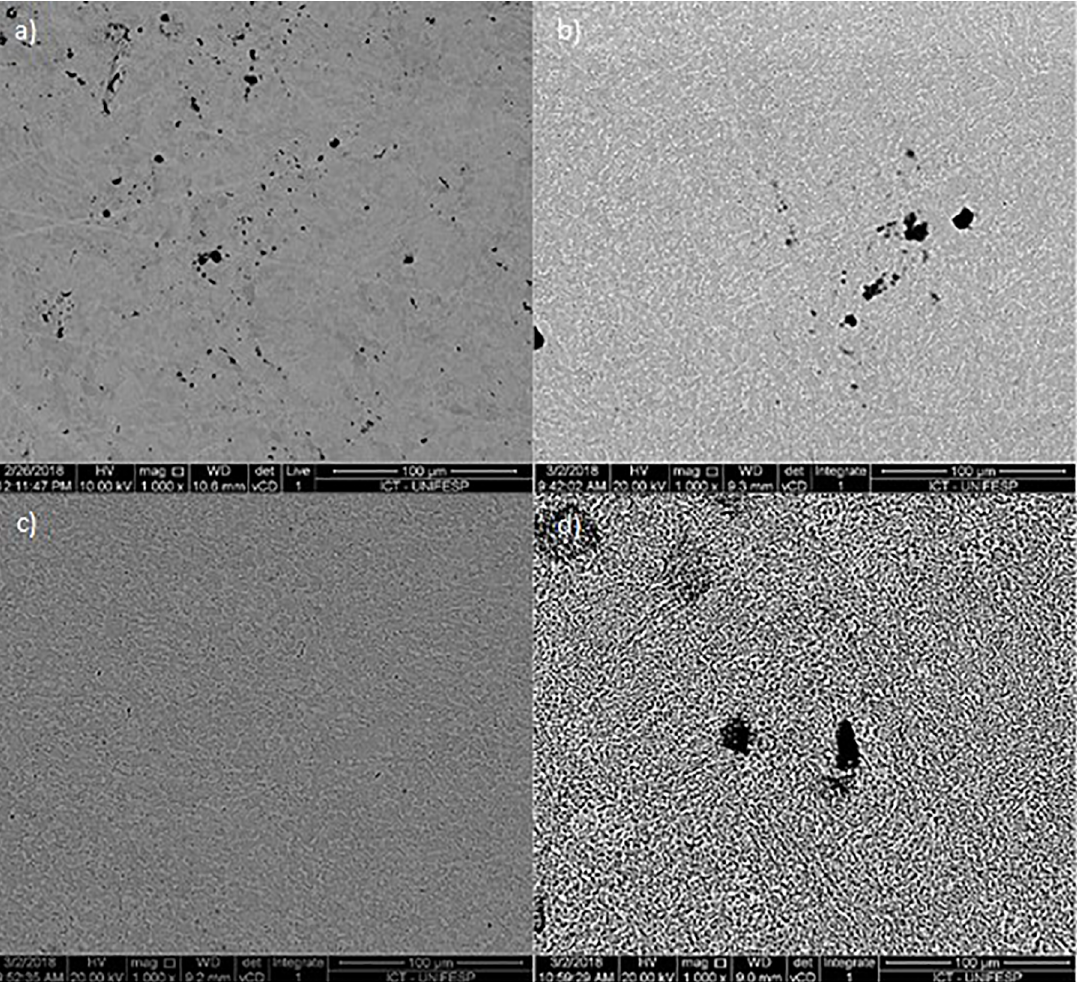
Figure 13 . SEM images after 2 h immersion in SBF: (a) untreated control and (b–d) samples etched by piranha solution for 30 min at 25 °C, 40 °C, and 60 °C, respectively.